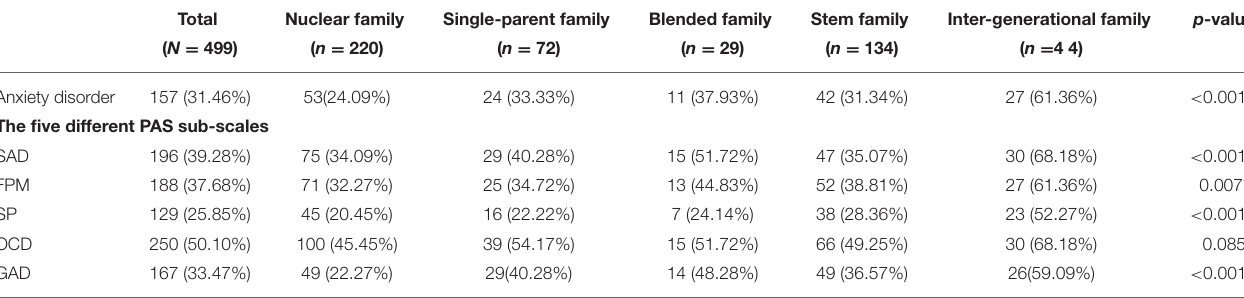
TABLE 2 | Prevalence of d Anxiety disorder and disorder of the five different PAS sub-scales by family structure. Total Nuclear family Single-parent family Blended family Stem family Inter-generational family p -value